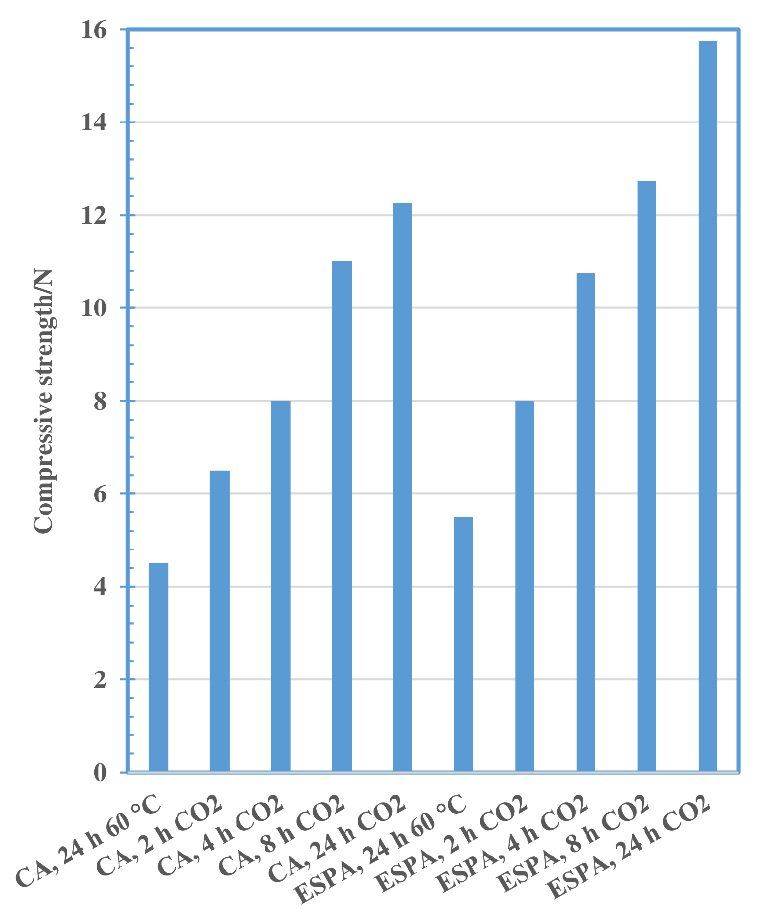
Figure 9. Compressive strength of granules (3–4 mm) with 10% of clay granulated with transportation water and stored in the atmosphere contained 15% of CO 2 .